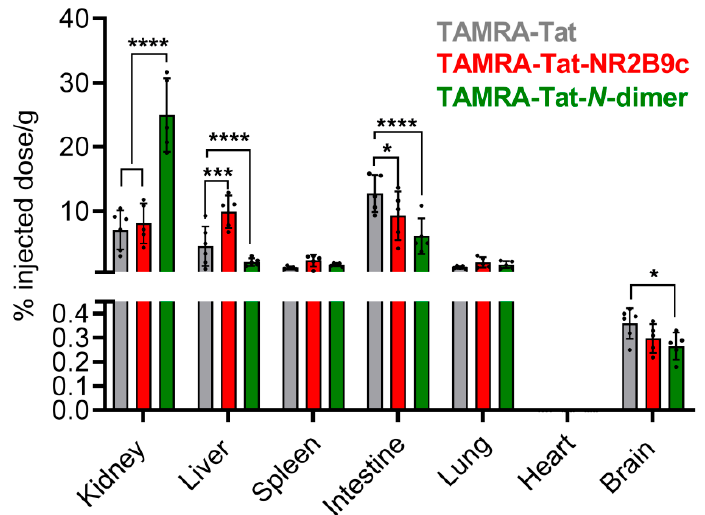
Figure 6. Biodistribution of TAMRA-Tat, TAMRA-Tat-NR2B9c, and TAMRA-Tat- N -dimer in tissues